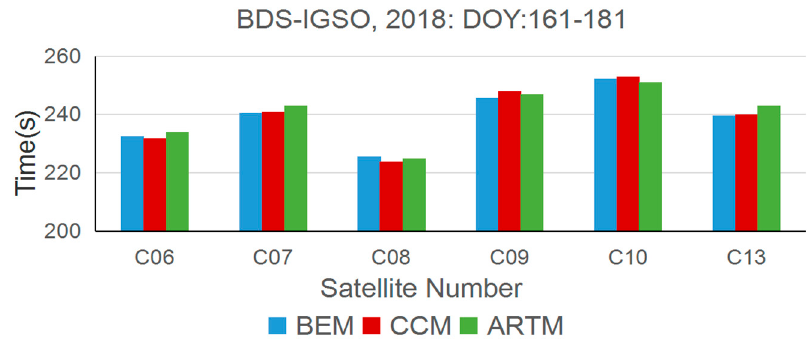
Figure 6. The mean shift time for BDS IGSO satellites calculated by the three methods during DOY: 161–181, 2018.